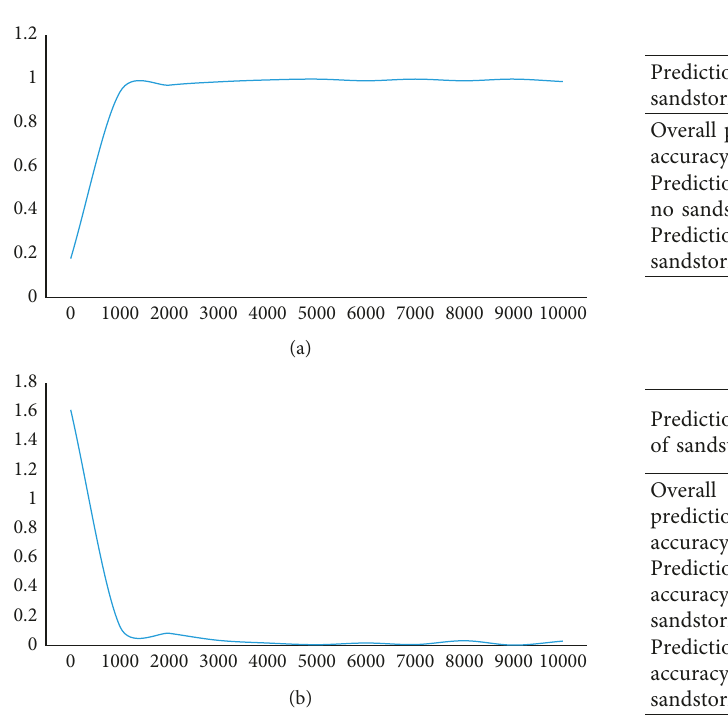
Figure 11: Accuracy curve and loss curve in inv learning strategy. (a) Accuracy curve. (b) Loss curve.